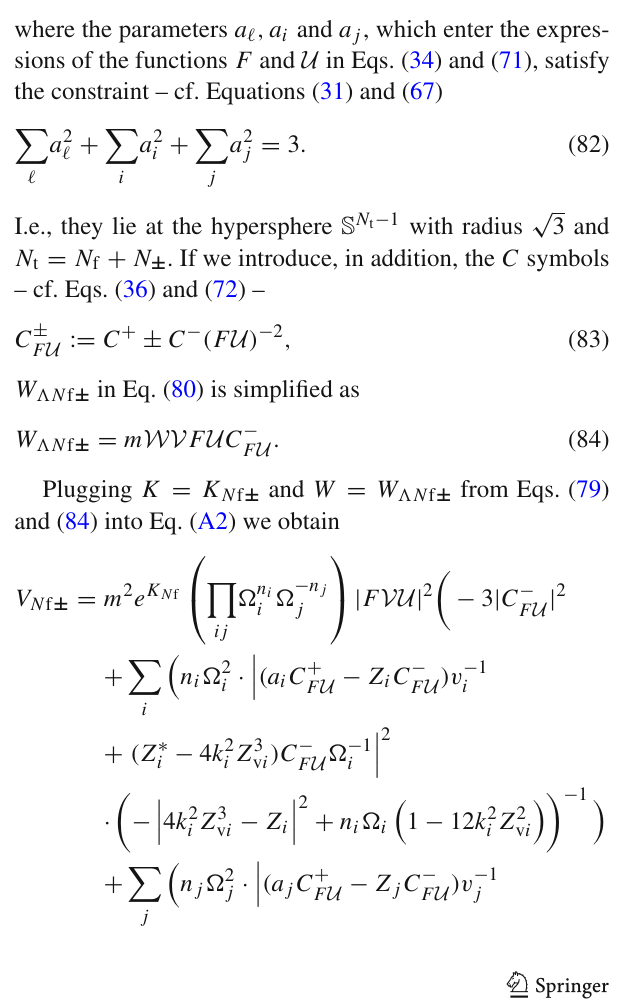
Fig. 4 The (dimensionless) SUGRA potential V +− / m 2 m 2 as a function of z 1 and z 2 in Eq. (17) for ¯ z 1 = ¯ z 2 = 0 and the inputs shown in column E of Table 1. The location of the dS vacuum in Eq. (26b) is also depicted by a thick black